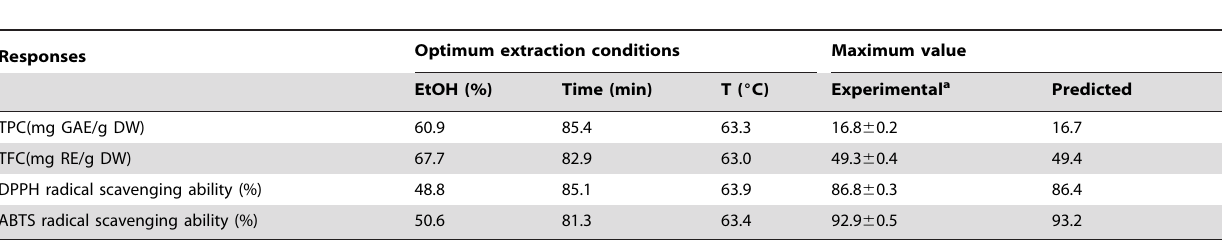
Table 3. Predicted and experimental values of response variables under optimal